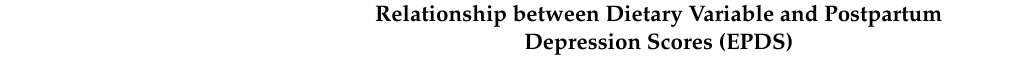
Table 2. Dietary intake and postpartum